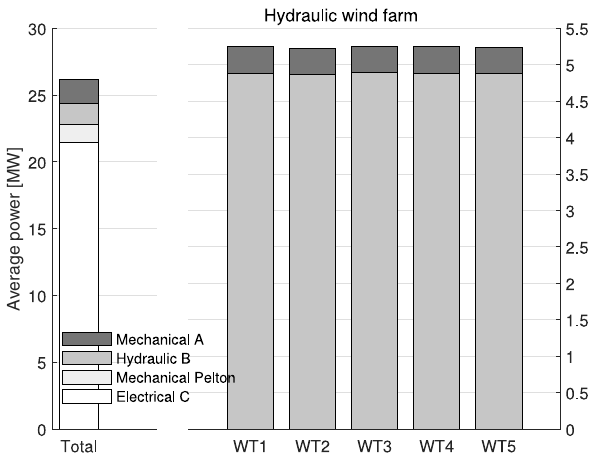
Figure 17. Power performance for the hydraulic wind farm, above rated